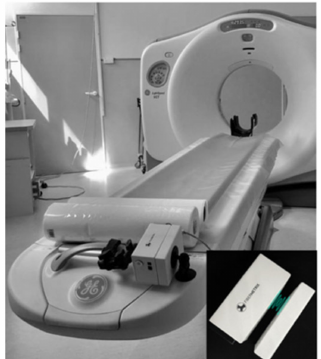
Figure 1. IVISCAN ® dosemeter installed on a CT scan. Illustration at the bottom right shows the photometer and the induction charging station.